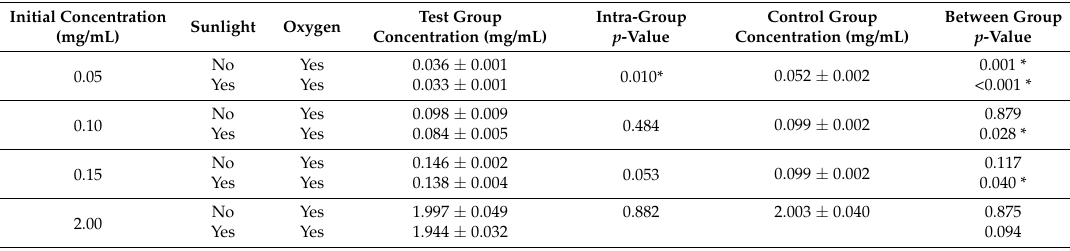
Table 6. The residual concentration of EGCG in the EGCG solution atomized by an ultrasonic scaler with oxygen: intra-group and between group analysis. Intra-Group Control Group Between Group Initial Concentration Sunlight Oxygen Test Group p -Value p Concentration (mg/mL) Concentration (mg/mL) (mg/mL)